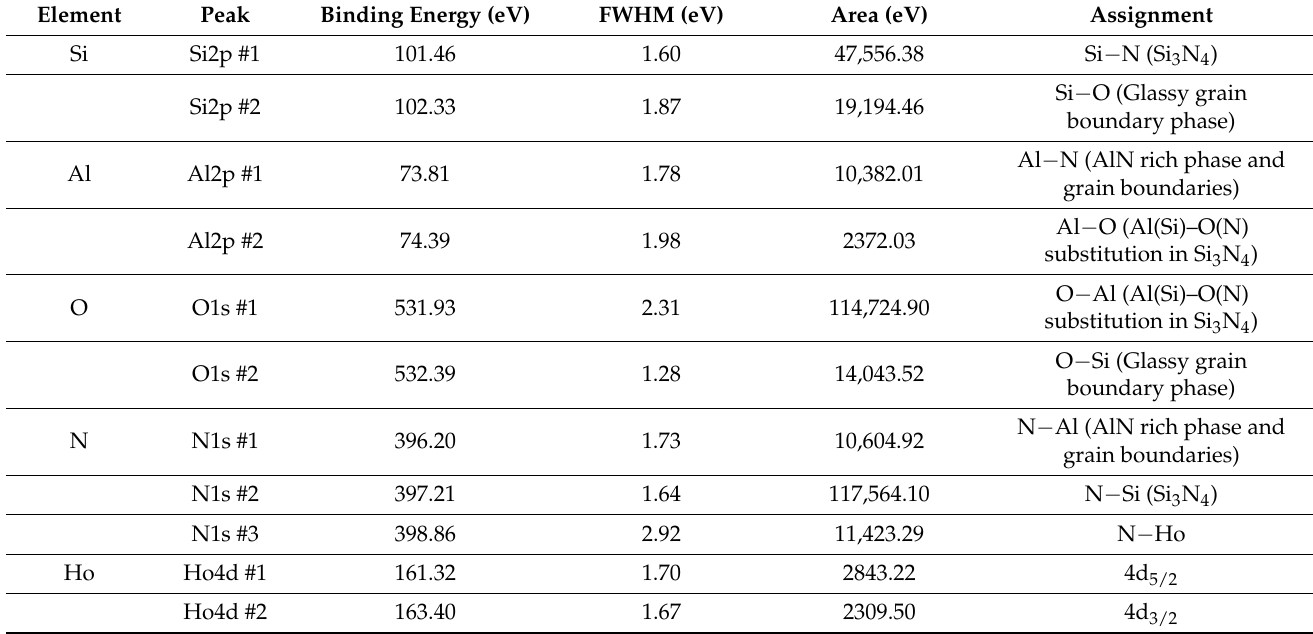
Table 2. List of binding energy, full width at half maxima (FWHM), area, and proposed chemical- bond assignments. Integer identifiers are assigned with the lowest binding energy sub-peak as #1 to the sub-peaks within a given elemental peak. The unit of binding energy, FWHM, and the area are electron volts